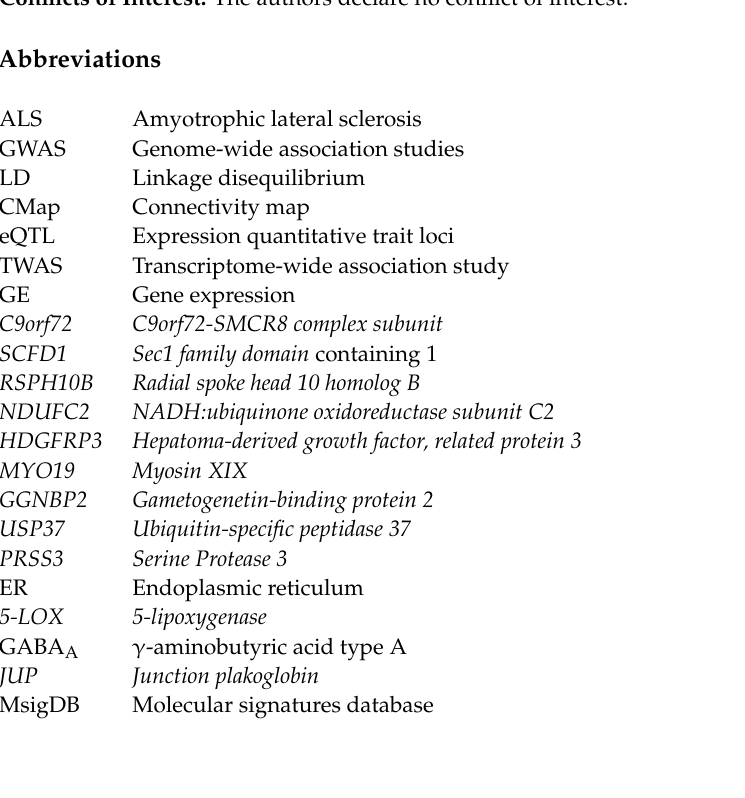
Table S3: Divide the loci of TWAS novel genes based on +/ − 500 kb, Table S4: Conditional analysis of multi-gene loci, Table S5: TWAS-GSEA result (FDR < 0.05) and enrichment gene set, Table S6: CMap permuted